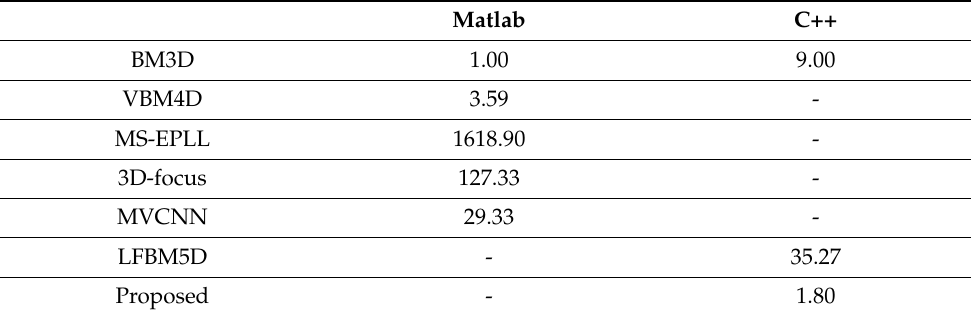
Table 7. Comparison of processing time.